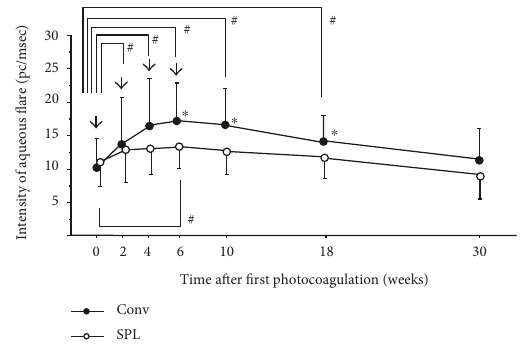
Figure 2: Changes in anterior fl are intensity (AFI) after four sessions of panretinal photocoagulation (PRP). Data represent mean ± standard deviation (SD). Arrow indicates the timing of PRP. # p < 0 05 (compared with AFI at PRP initiation), ∗ p < 0 05 (Conv group versus SPL group).